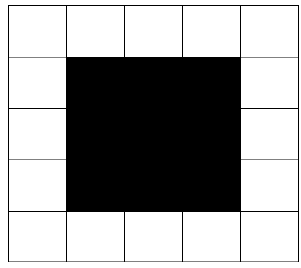
Figure 5. Concave obstacle filling.